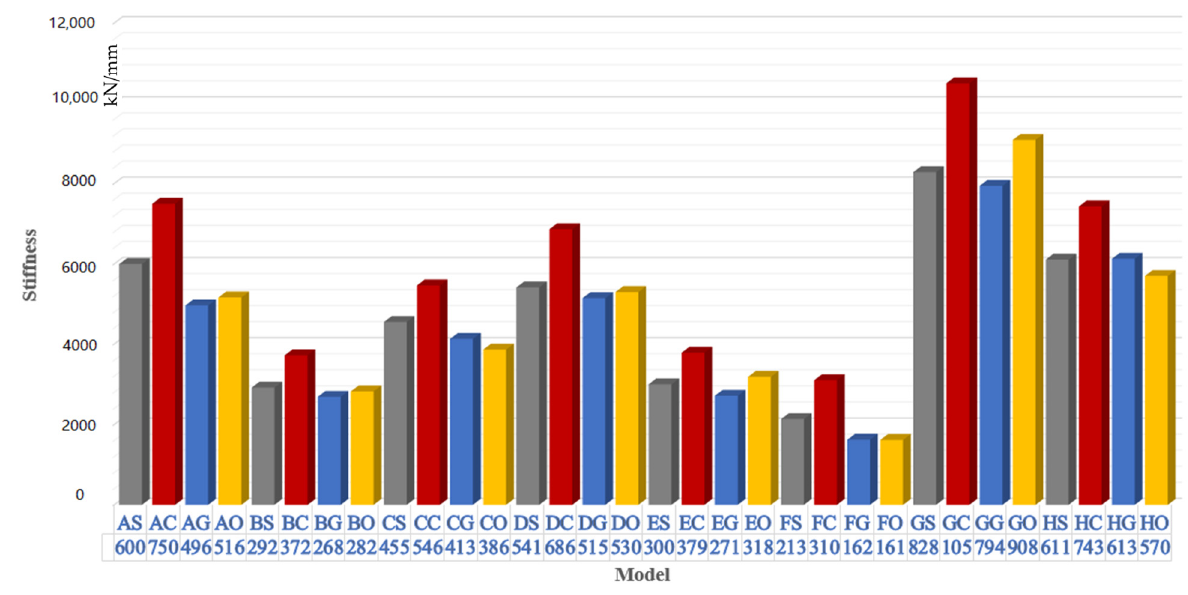
Figure 17. Stiffness of the models.